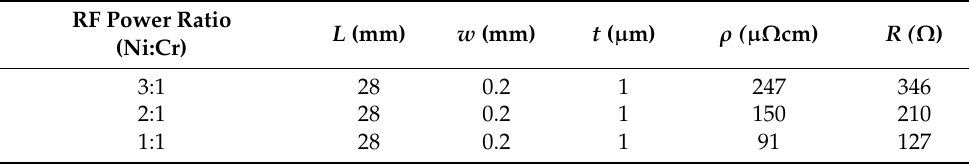
Figure 2. Resistivity of the samples via Hall measurement. Table 1. Characteristics of the designed microconstruction.